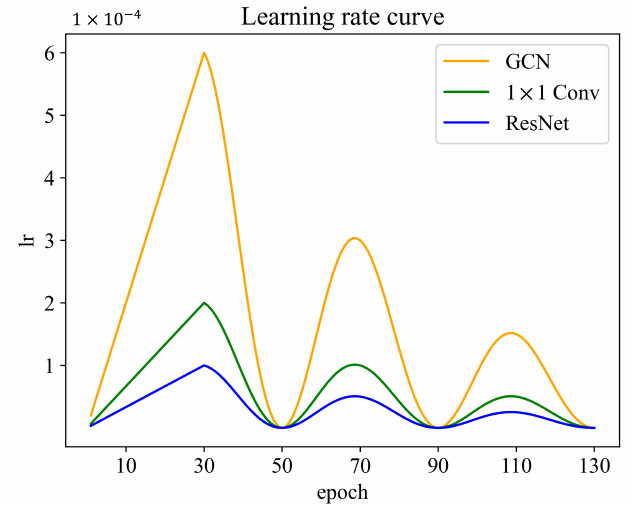
Figure 5. Learning rate schedule, which combines the warm-up strategy, cosine annealing warm restarts schedule, and periodic decay. The maximum learning rates of different components in CHeGCN are different.